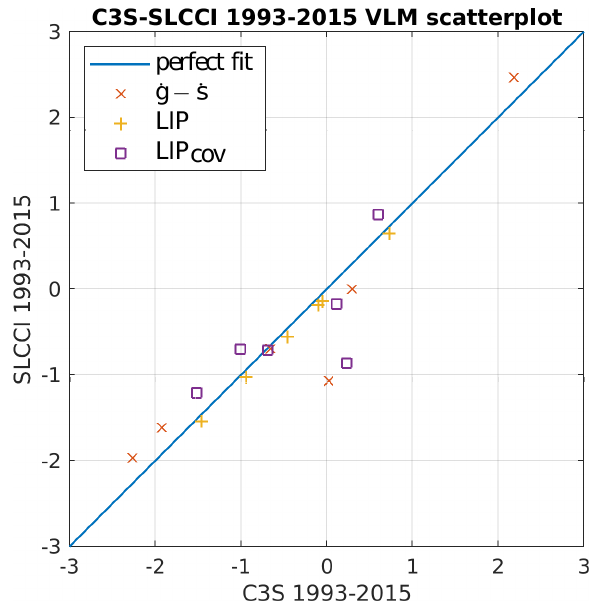
. . g − s ), LIP method, and LIP cov